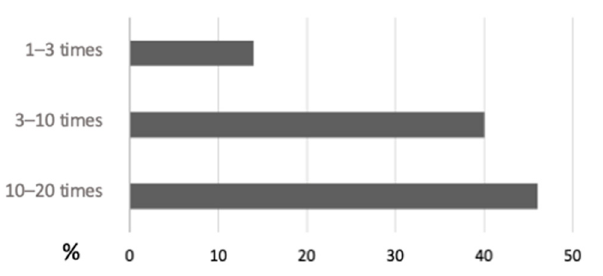
Figure 5. Number of sensor scans per day carried out by dog and cat owners when using the flash glucose monitoring system.